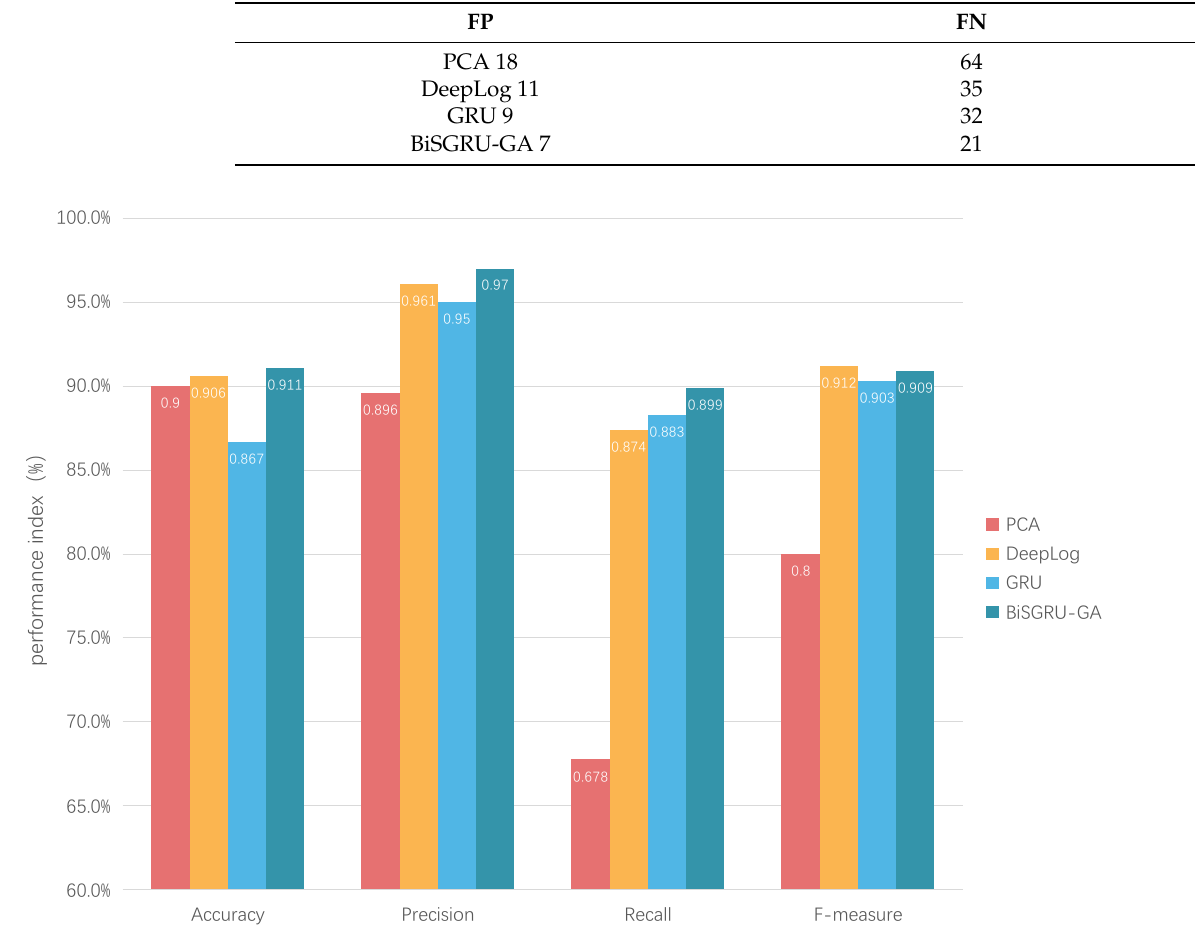
Table 3. Performance comparison of PCA, DeepLog, GRU.